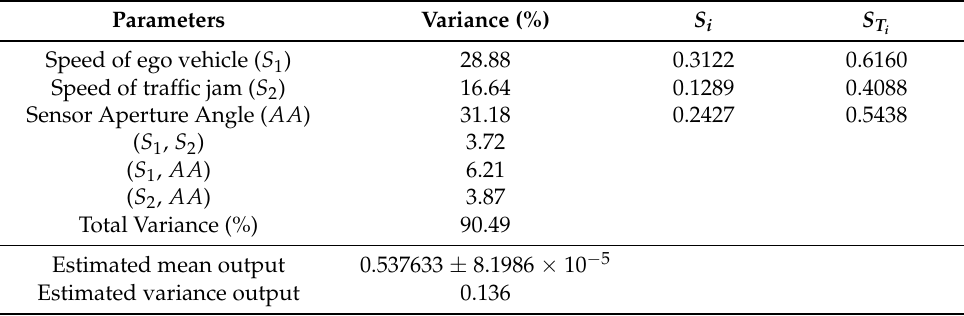
Table 4. The emulator-based SA of the traffic jam scenario (c.f. Section